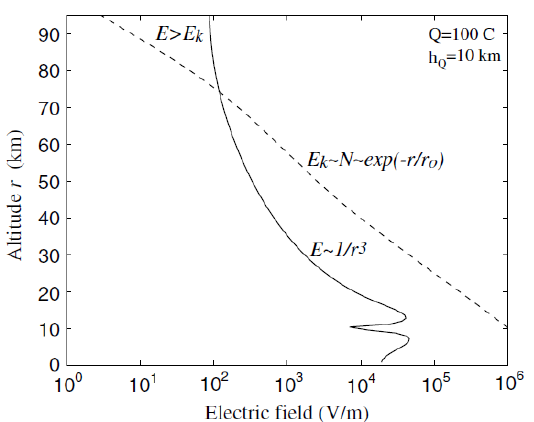
Fig. 3. Physical mechanism of red sprites. At higher altitudes the lightning driven electric field (E) exceeds the dielectric strength of air i.e. conventional breakdown electric field (E k ) results in discharges named red sprites [50]. In this Fig. Q is the thundercloud charge and h Q is the height from which Q is removed by the causative +CG lightning.